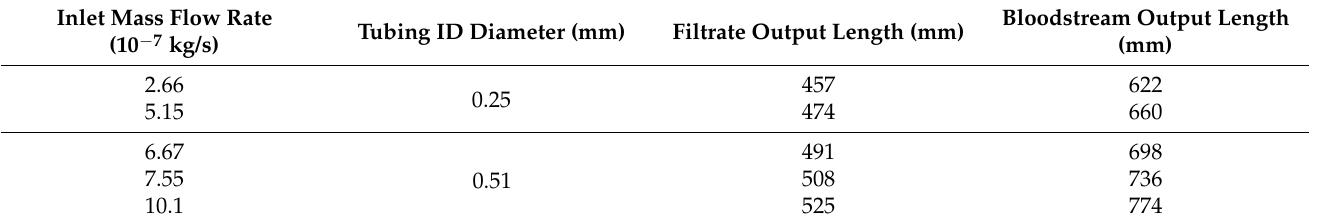
Table 1. MPS Critical Parameterizations.